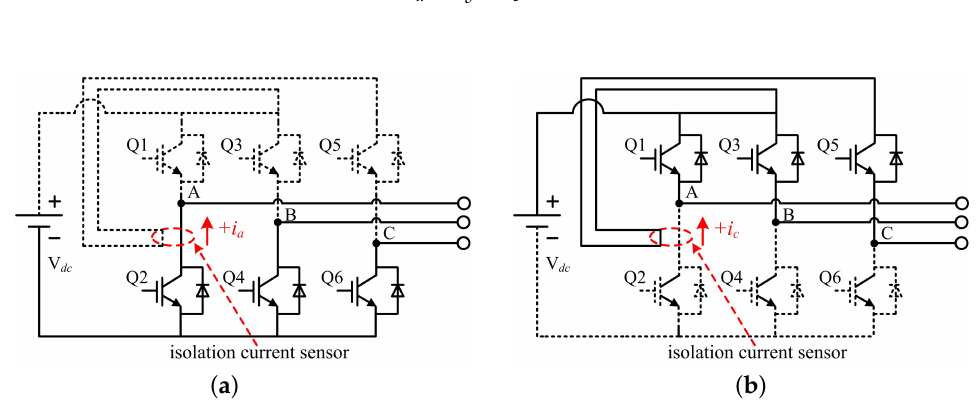
Figure 5. The current flow paths during two zero voltage vectors. ( a ) V 0 (000); and ( b ) V 7